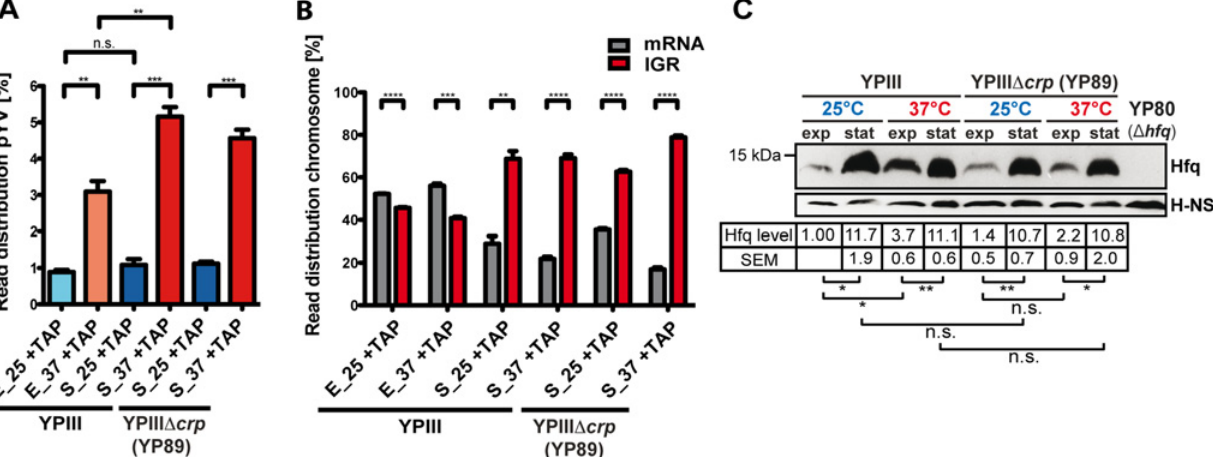
Fig 1. Global cDNA read count distribution and Hfq levels in Y. pseudotuberculosis during growth under environmental and infection-relevant conditions. (A) Percentage of uniquely mapped reads of the virulence plasmid pYV obtained by RNA-seq of Y . pseudotuberculosis YPIII and YPIII Δ crp cDNA libraries. Libraries were generated from TAP-treated (+TAP) rRNA depleted RNA obtained from cultures grown to exponential (E) or stationary (S) growth phase at 25°C (25) and 37°C (37) (for detailed statistics see S1 Dataset). The data represent the mean ± SEM from three independent biological replicates and were analyzed with Student ’ s t-test. ** : P < 0,01; *** : P < 0,001; n.s.: not significant. (B) Percentage of uniquely mapped reads to annotated ORFs (mRNA) or intergenic regions (IGR) of the YPIII genome. IGR reads do not include 5 ’ -UTRs of mRNAs, rRNAs and tRNAs, and mostly represent trans - encoded sRNAs. The data represent the mean ± SEM from three independent biological replicates and were analyzed with Student ’ s t-test. ** : P < 0,01; *** : P < 0,001; **** : P < 0.0001. (C) Growth phase- and temperature-responsive expression of Hfq in Y . pseudotuberculosis YPIII and the isogenic crp deletion strain YP89. Equal amounts of whole cell extracts of YPIII or YP89 grown to exponential (exp) or stationary phase (stat) at 25°C or 37°C were separated by SDS-PAGE prior to Western blotting using polyclonal Hfq or H-NS antibodies (loading control). As a negative control YP80 (YPIII Δ hfq ) was included. Relative protein amounts were quantified using ImageJ. The data represent the mean ± SEM from three independent experiments and were analyzed with Student ’ s t-test. * : P < 0,05; ** : P < 0,01; n.s.: not